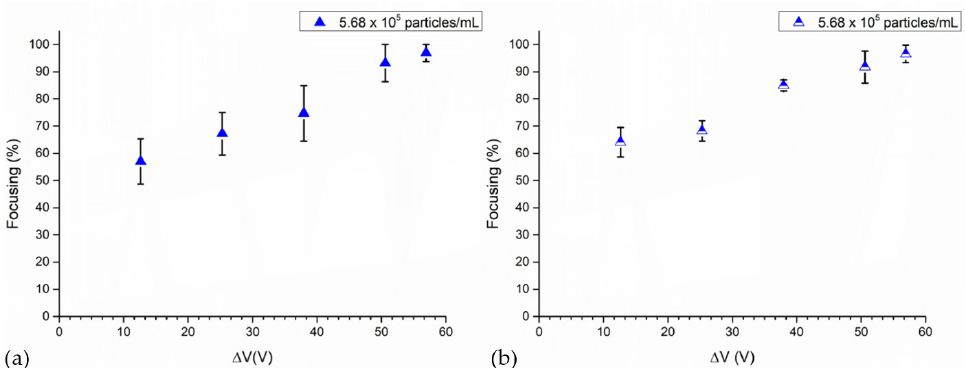
Figure 5. Focusing performance of the BAW device as a function of applied voltages at the trans- ducer: ( a ) UV–Vis characterization and ( b ) image analysis. During the experiments, 4MPs concen- trated at 5.68 × 10 5 particles/mL were injected at 3 µL/min into the device actuated at its resonant frequency of 4.623 MHz, while 56.92 Vpp, 50.59 Vpp, 37.95 Vpp, 25.29 Vpp and 12.65 Vpp were applied at the transducer.